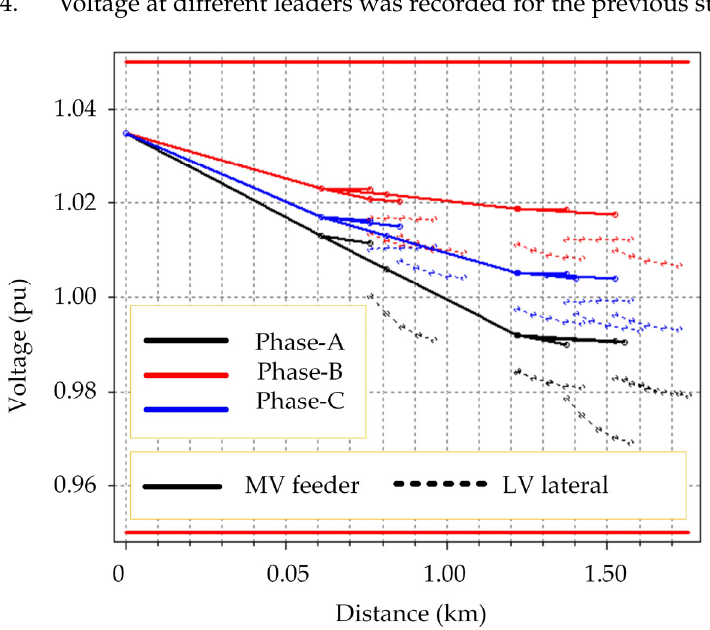
Figure 11. Voltage profile for the simulated system at rated conditions.